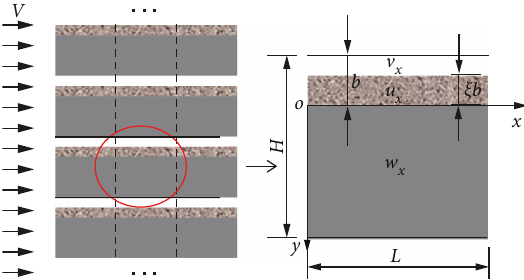
Figure 1: Model of rock mass with periodic partially fi lled